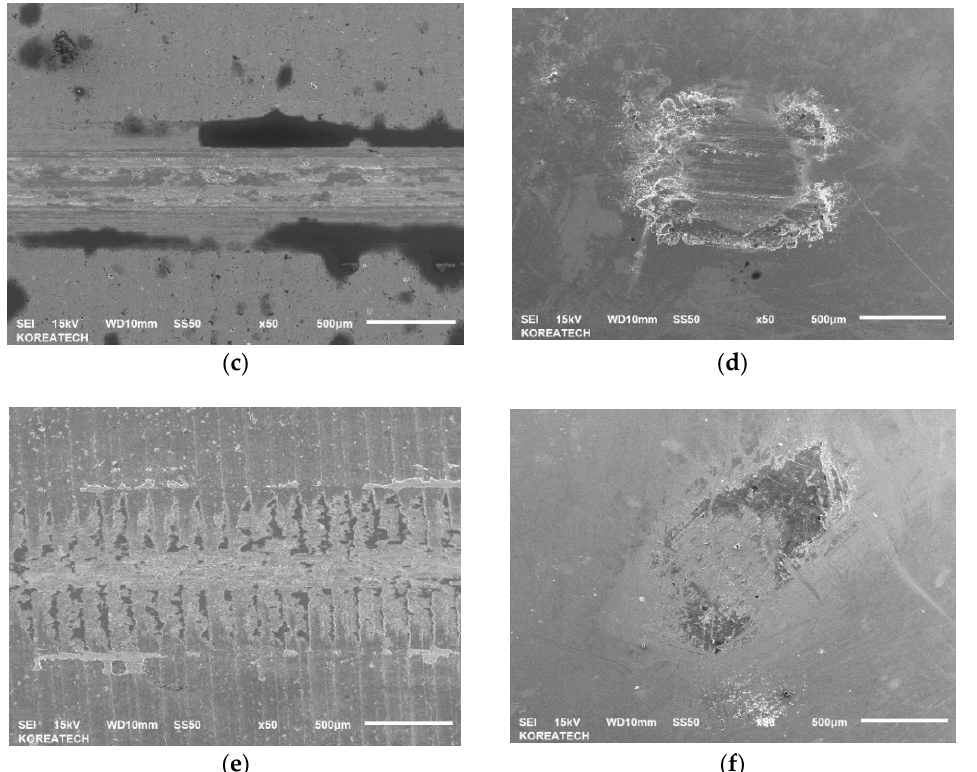
Figure 12. SEM images and mappings of the wear track formed on the surface of the as-PM ( a , b ), UNSM-25 ( c , d ) and UNSM-300 ( e , f ) samples.